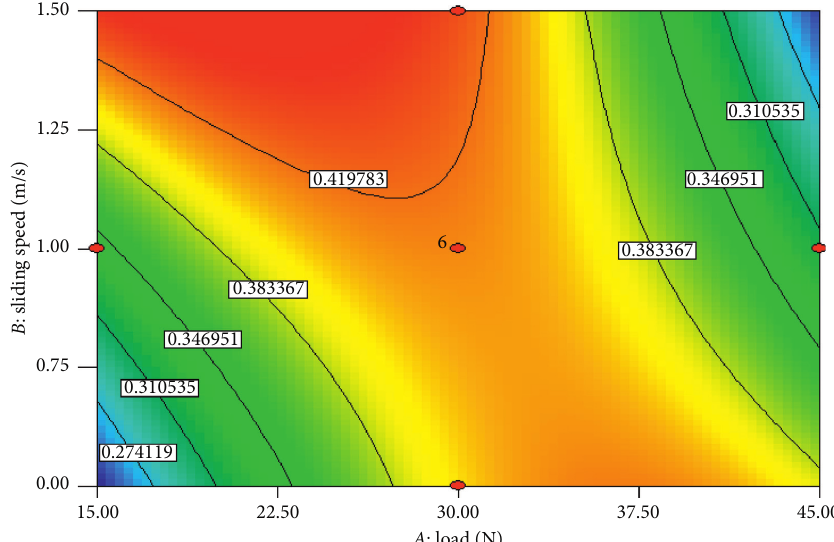
Figure 8: Contour plot of COF.